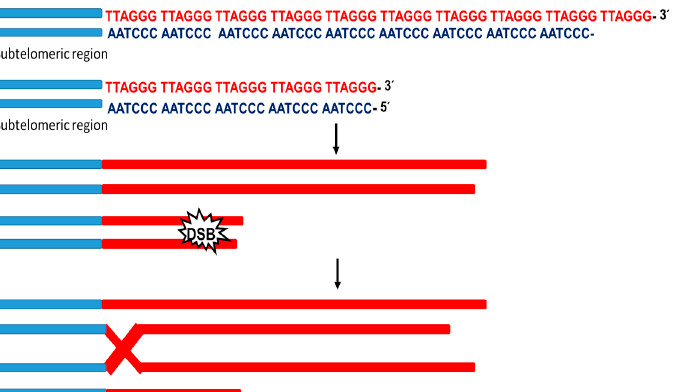
Figure 3. BIR mechanism. Schematic representation of the telomere replication process induced by dsDNA damage. When the dsDNA is damaged, repair mechanisms are activated at the ends of the telomeres. The damaged strand invades the telomeric region of the donor and serves as a primer for the replicative process initiation.